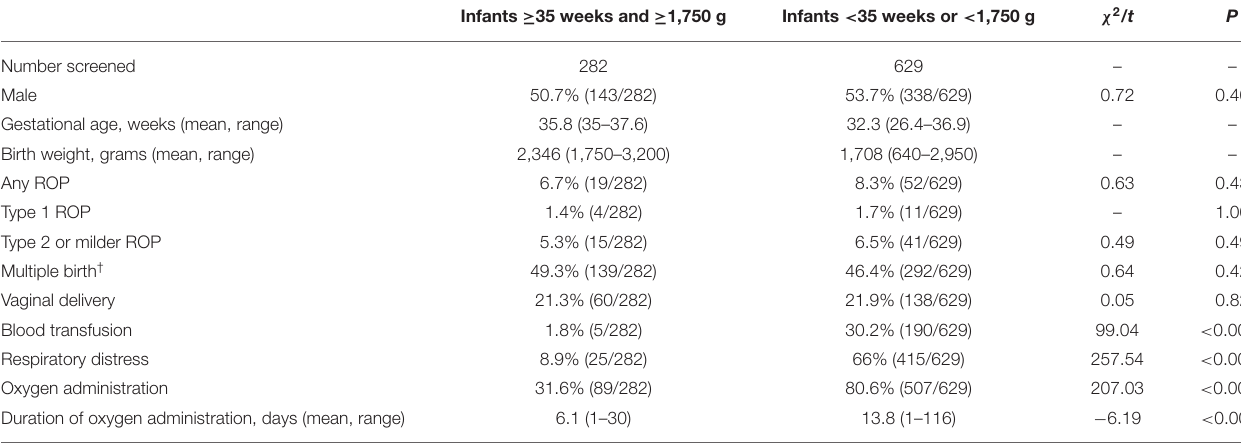
TABLE 1 | Characteristics of premature infants with both late gestational age and large birth